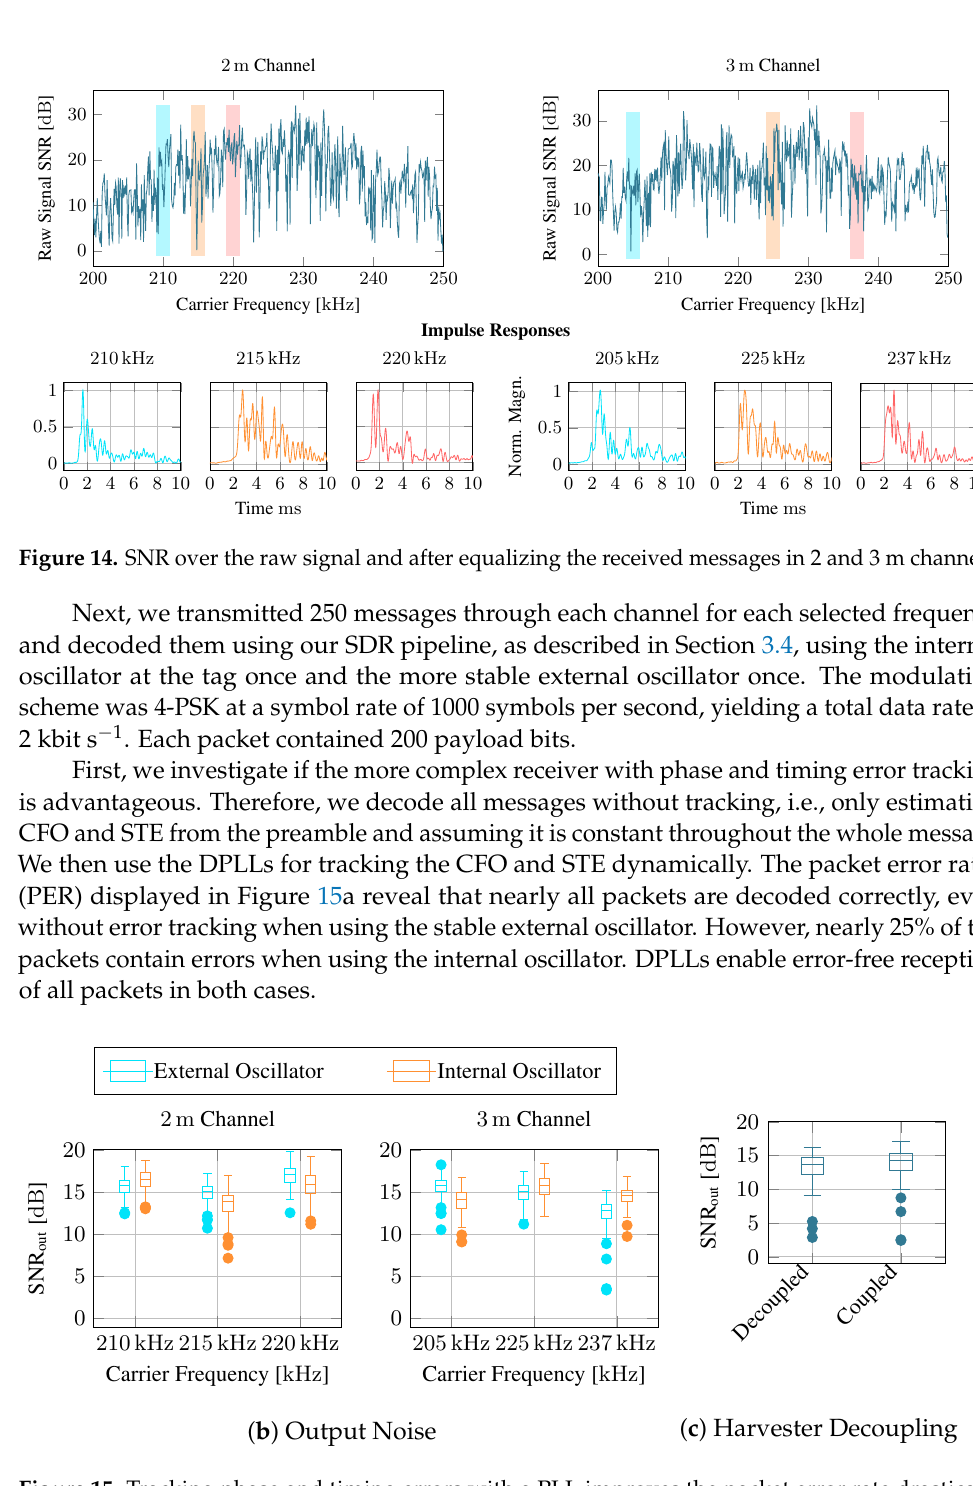
Figure 15. Tracking phase and timing errors with a PLL improves the packet error rate drastically when using the unstable internal oscillator ( a ). When using a PLL, internal and external oscillators perform similarly, and all messages are received and decoded correctly in the channels under test ( b ). The switch used to decouple the harvester from the modulator circuit does not significantly impact output SNR ( c ). All recorded messages are available in Supplementary Material Data